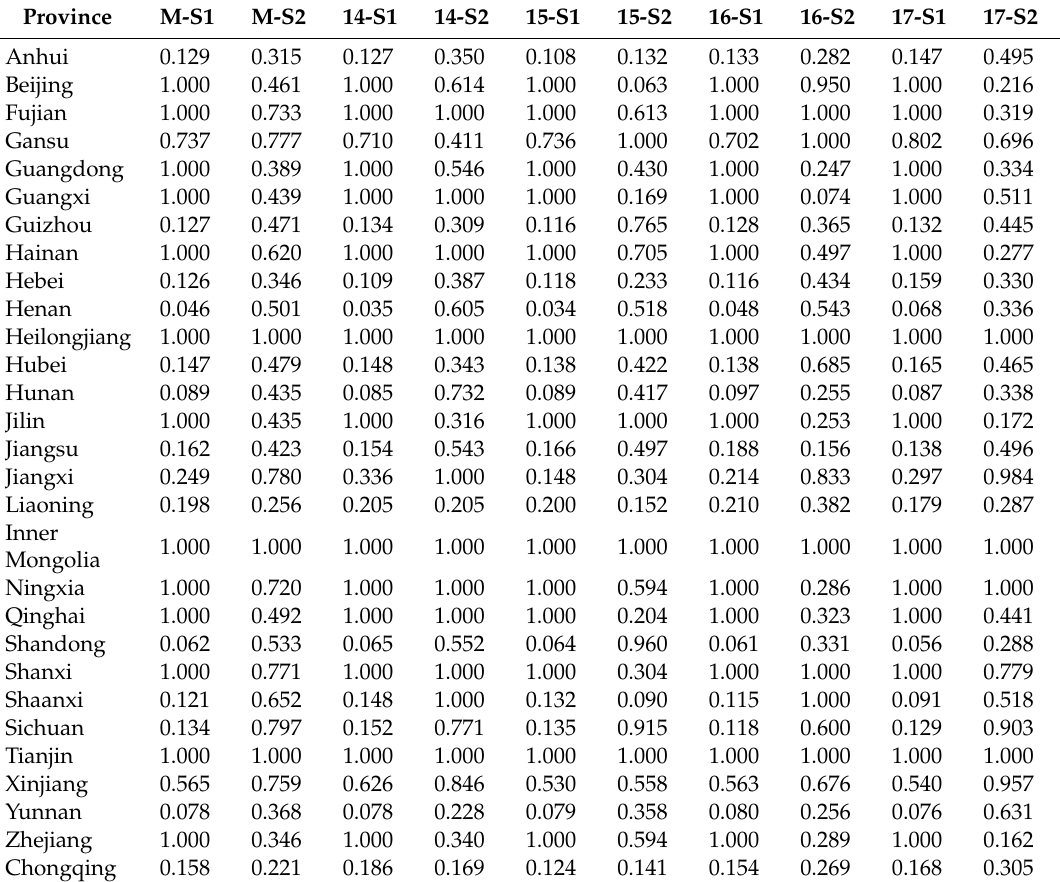
Table 4. Mining production stage and rehabilitation stage e ffi ciencies from